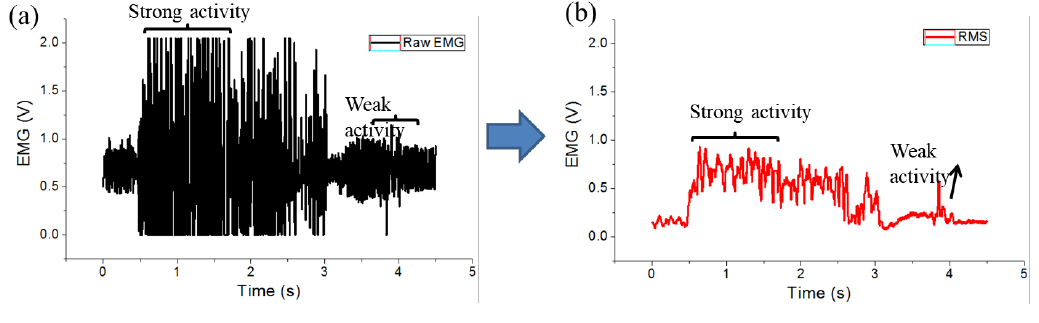
Figure 8. EMG signal processing for RMS analysis: ( a ) raw EMG signal; ( b ) RMS of EMG signal.